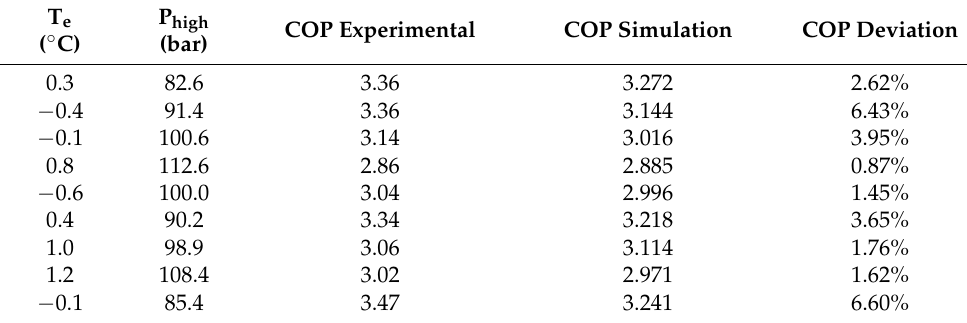
Table 2. Validation evidence about the heat pump cycle with Reference